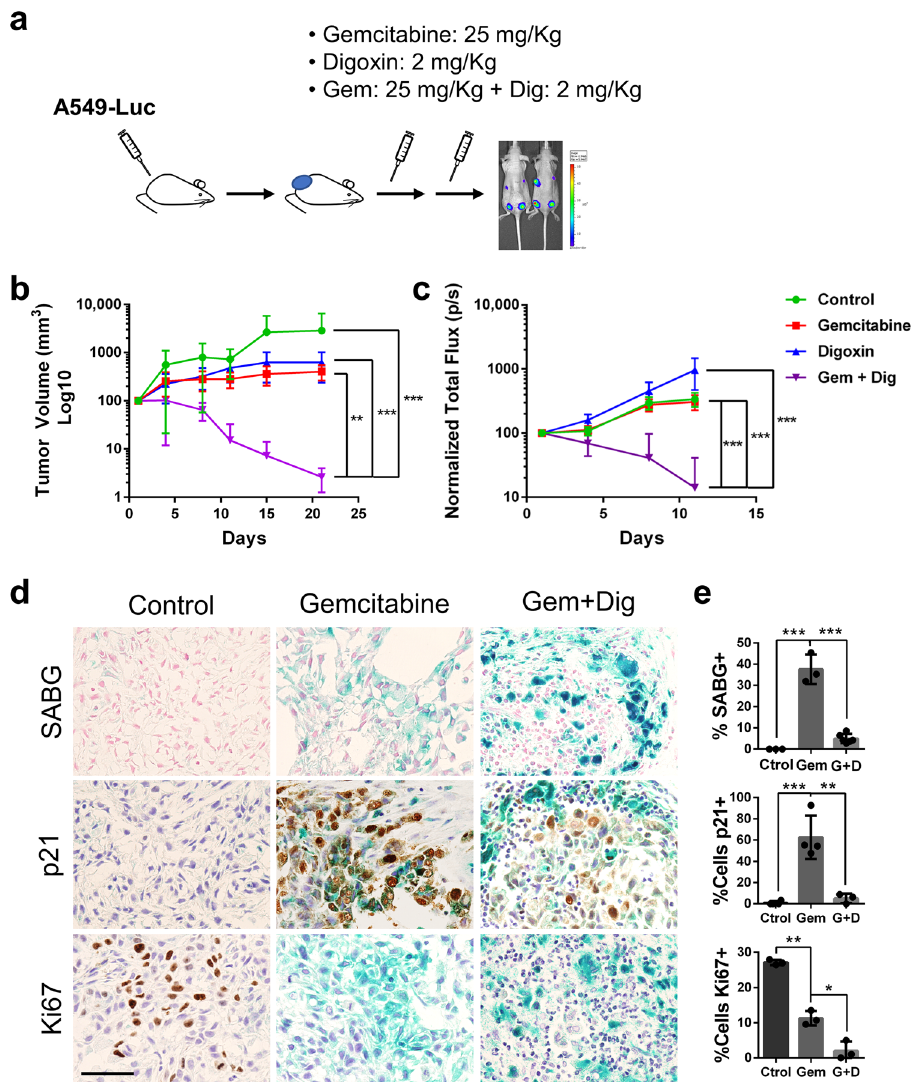
Fig. 4 Senolytic activity of Digoxin on xenografts. a Diagram showing the experimental plan to test the effect of administrating Gemcitabine, Digoxin or the combination of both (Gem + Dig) in the growth of A549 cells expressing luciferase (A549-Luc) as subcutaneous tumors in nude mice. b Tumor volume (mm3) progression with time after intraperitoneal injection of Gemcitabine ( n = 12), Digoxin ( n = 8) or the combination of both (Gem + Dig) ( n = 12), or vehicle ( n = 4) as negative control as indicated. Statistical analysis was performed with Anova with Tuckey test: *** p < 0.001; ** p < 0.01. c Tumor growth determined by measuring normalized total fl ux of luminescence as detected by IVIS with the same groups of animals. Statistical analysis was performed with Anova with Tuckey test: *** p < 0.001. d Representative images of SABG staining (upper panels) and immunohistochemical analysis of p21 (middle panels) and Ki67 (bottom panels) in tumors obtained after injection of A549 cells in nude mice and treated with Gemcitabine, Gemcitabine plus